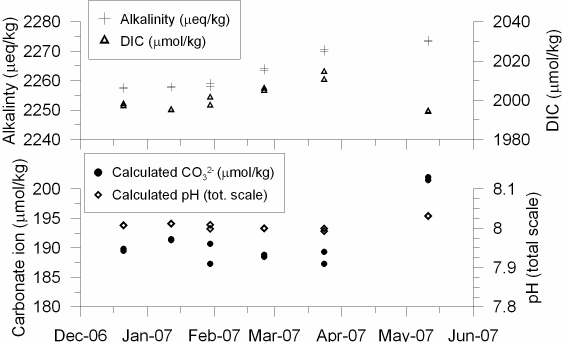
Fig. 3. Water chemistry data during the course of the experiment. Alkalinity and DIC were analyzed from water samples from the reservoir tank, and used to calculate [CO 2 − ] and 3